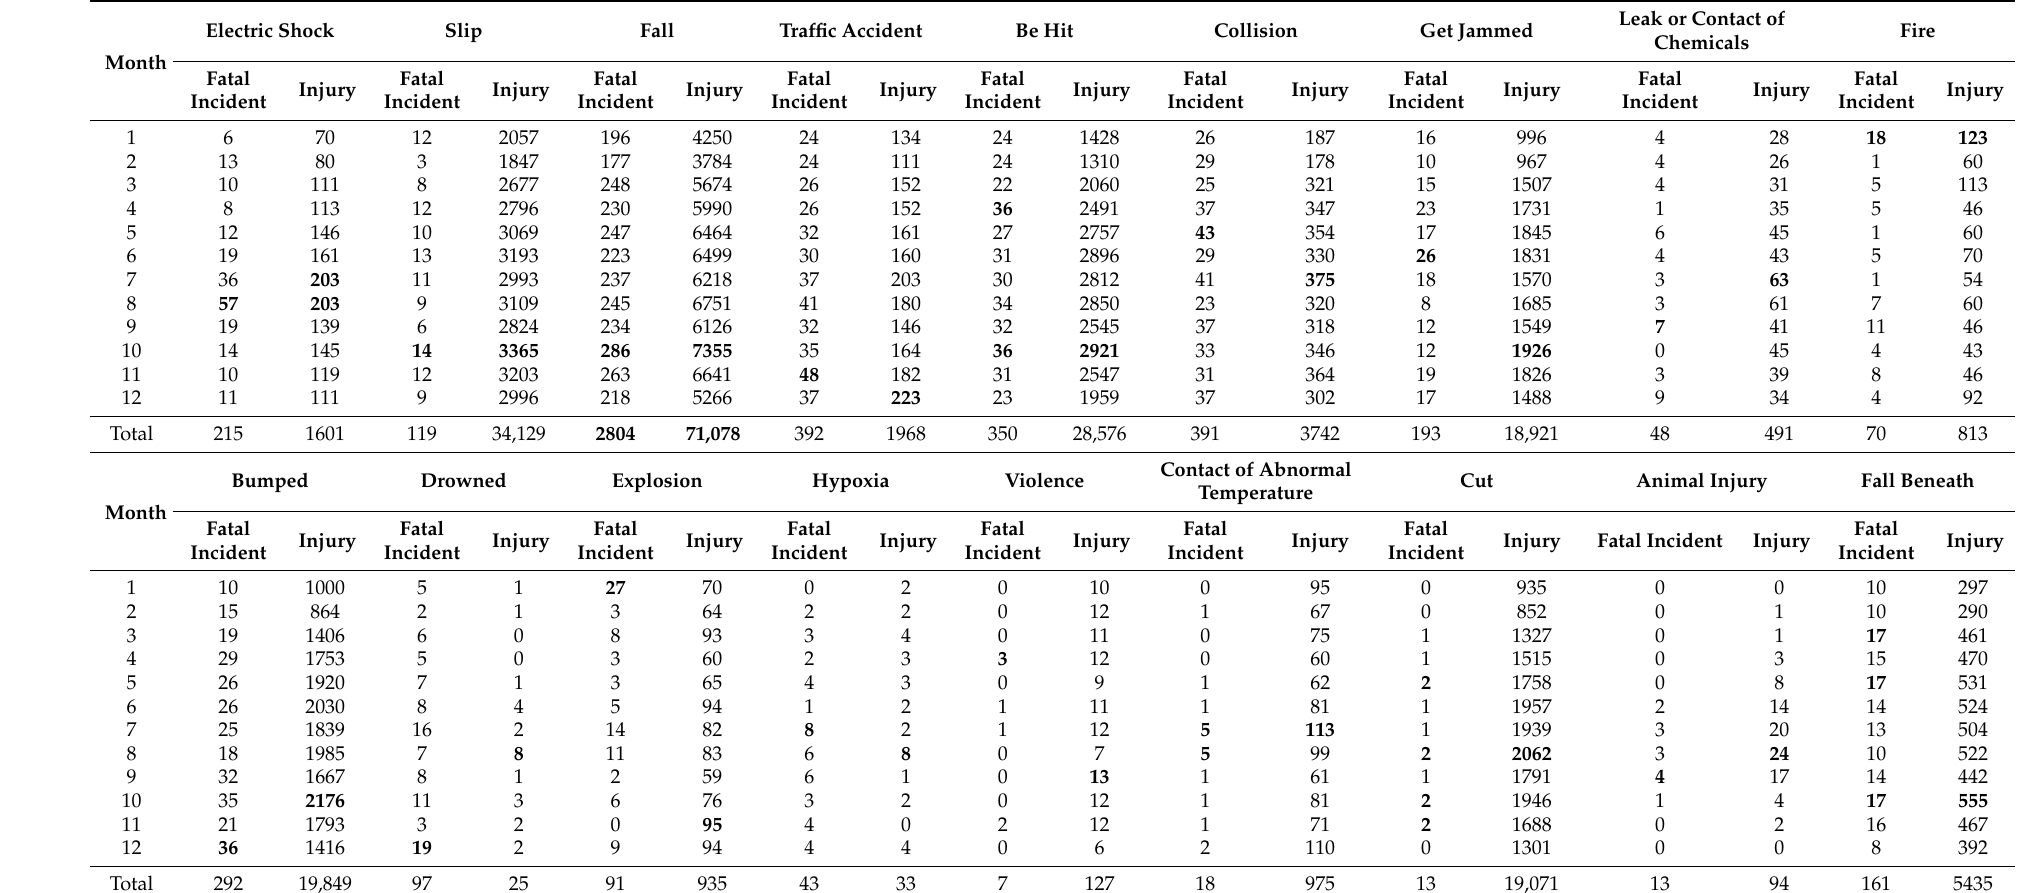
Table 5. Monthly analysis of injury and fatal accidents by accident